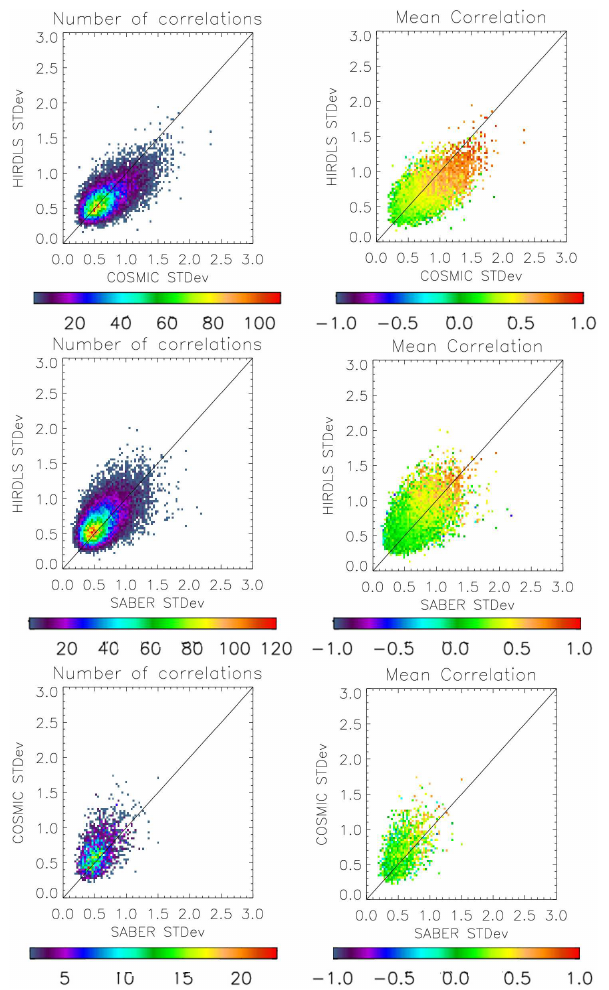
Fig. 3. Correlation-standard deviation analysis output for (top panel) HIRDLS-COSMIC, (middle panel) HIRDLS-SABER and (bottom panel) COSMIC-SABER profile pairs. The left-hand plot shows the data as a scatter of the standard deviations of the two instrument profiles, and the right the same plot but with the corre- lation values between the two instruments shown. In the left figure, the colour scale represents the number of points in each bin, whilst in the right figure the colour represents the mean correlation for profile-pairs in that